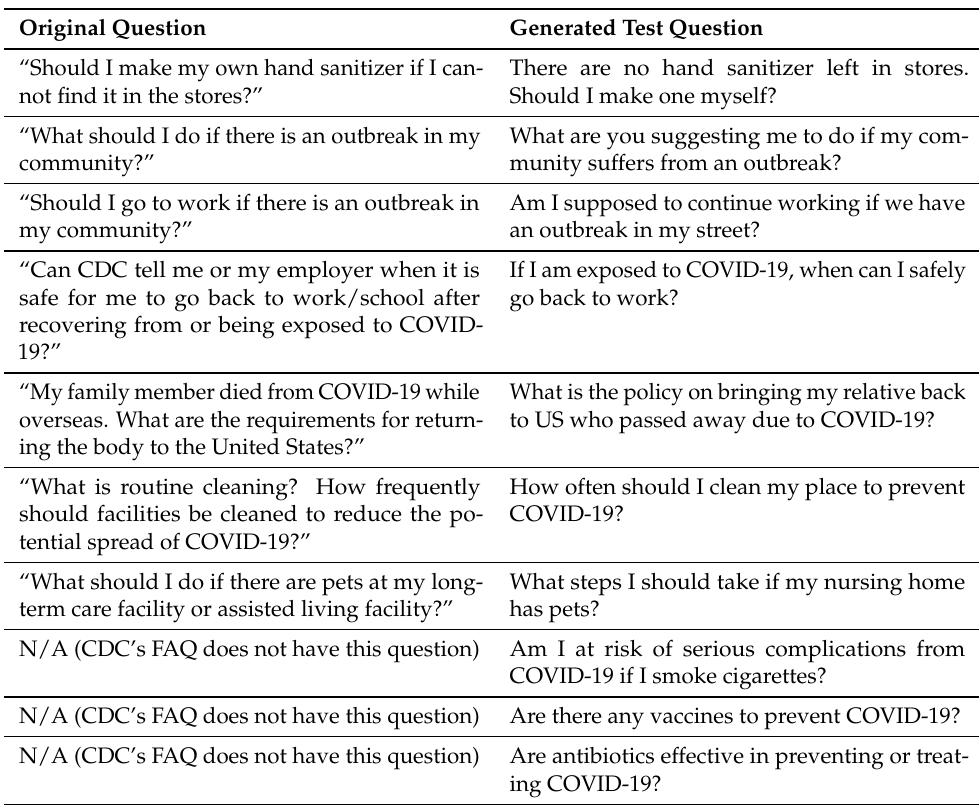
Table 1. Example Questions from the Test